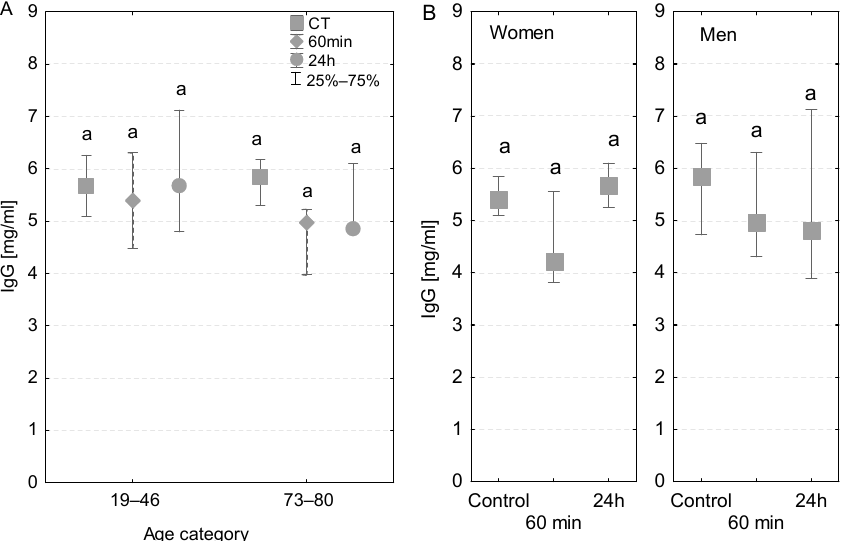
Figure 2. Serum IgG concentration (median ± quartile deviation; 25th and 75th percentiles). ( A ) Comparison based on the age of patients: 19–46 years and 73–80 years. ( B ) Comparison based on the sex of the patients. CT: measurement before the onset of CPB; 60 min: measurement at 60 min of the CPB onset; 24 h: measurement at 24 h after the onset of CPB. The same letters (a) indicated no statistical differences within age or sex category (Friedman’s or Mann–Whitney U test; p < 0.05.).